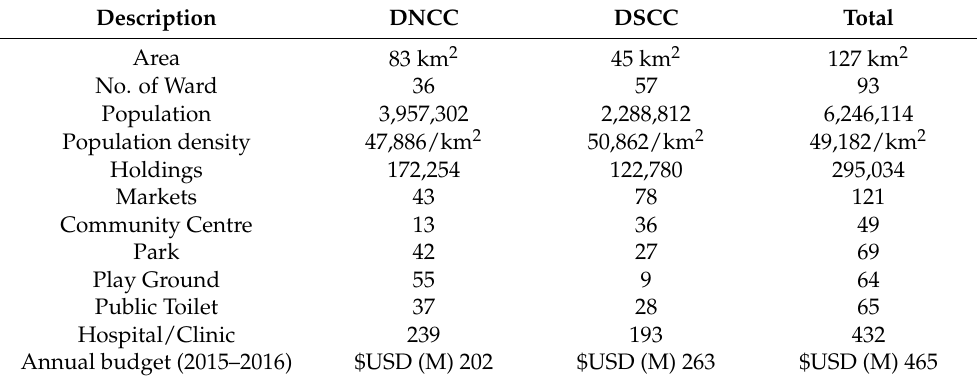
Table 2. The key demographic and urban features of Dhaka City corporations